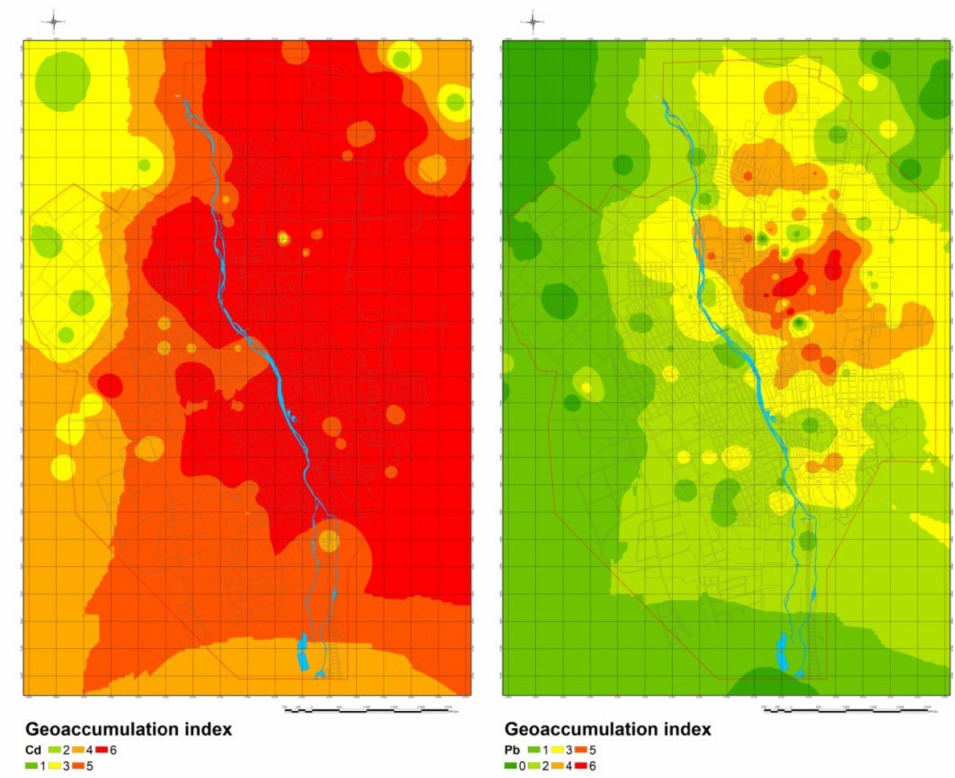
Figure 4. Geoaccumulation index of cadmium and lead for the territory of Vladikavkaz.